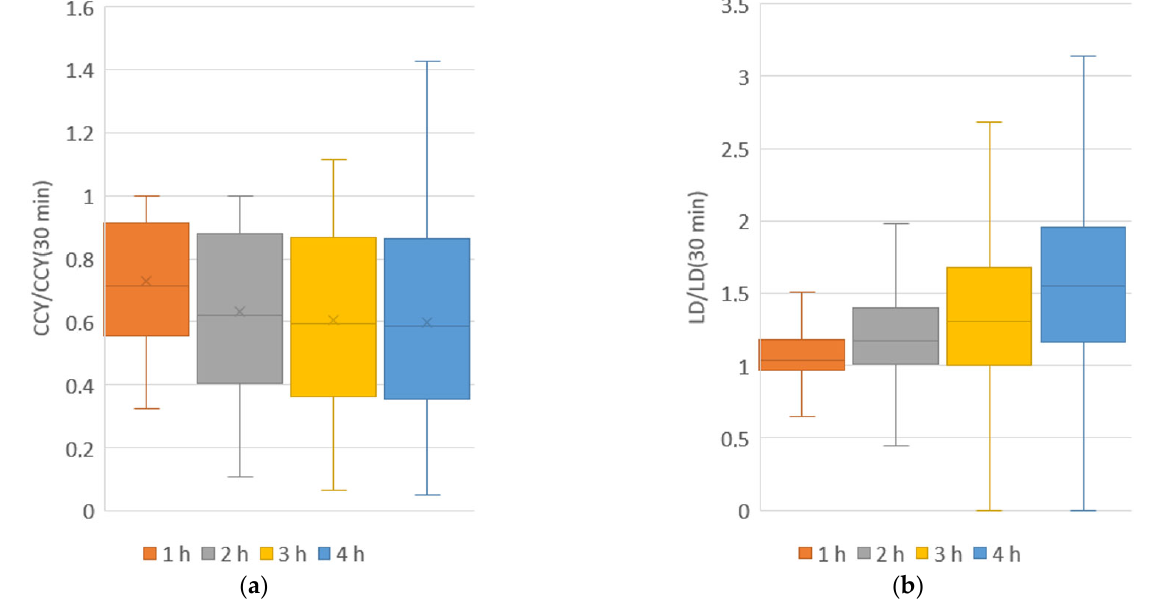
Figure 6. Diagrams of ( a ) CCY and ( b ) LD for station ID 23005. One ‐ year datasets.